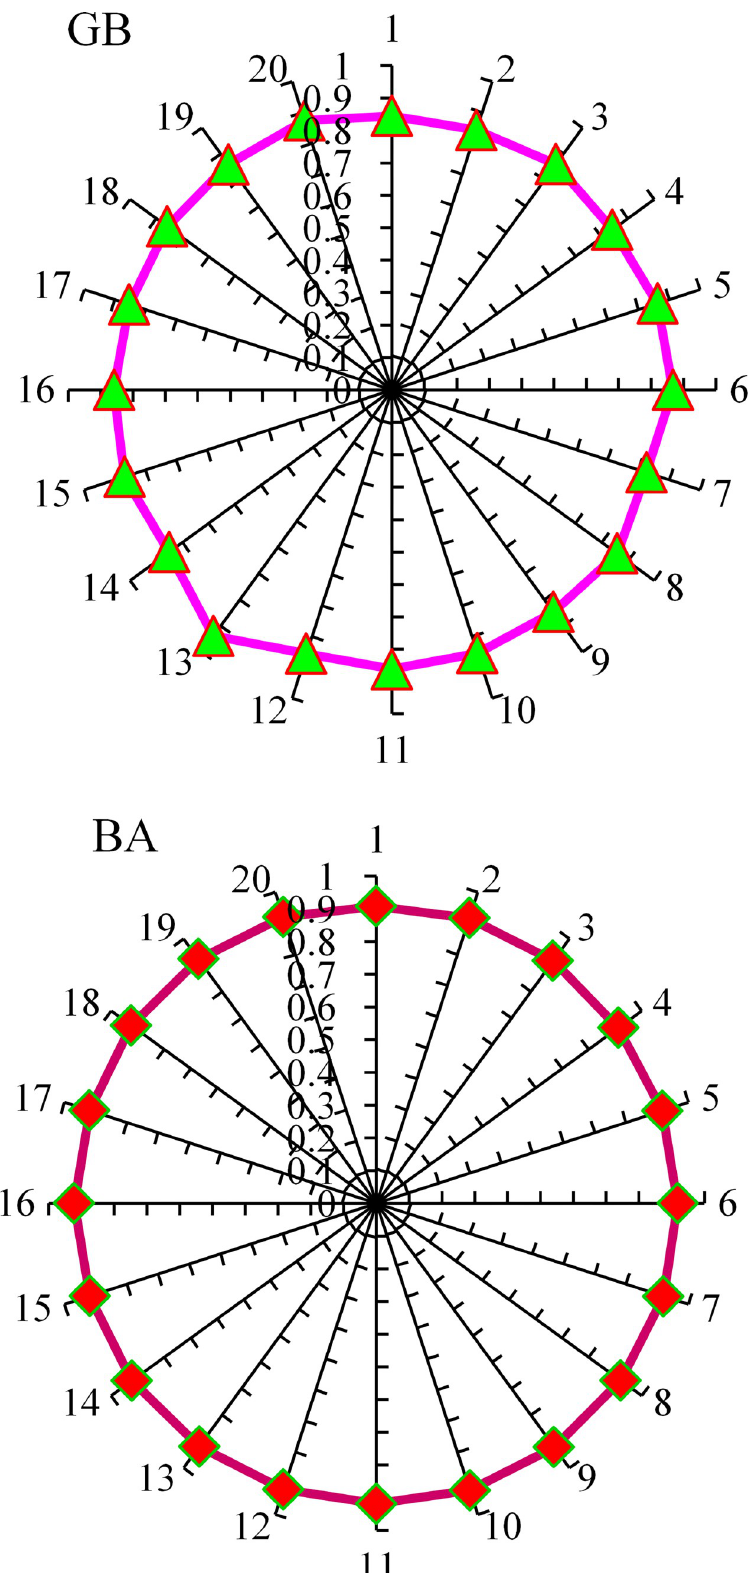
Fig 19. Sub-model results for compressive strength: (a) GB; (b) BA.